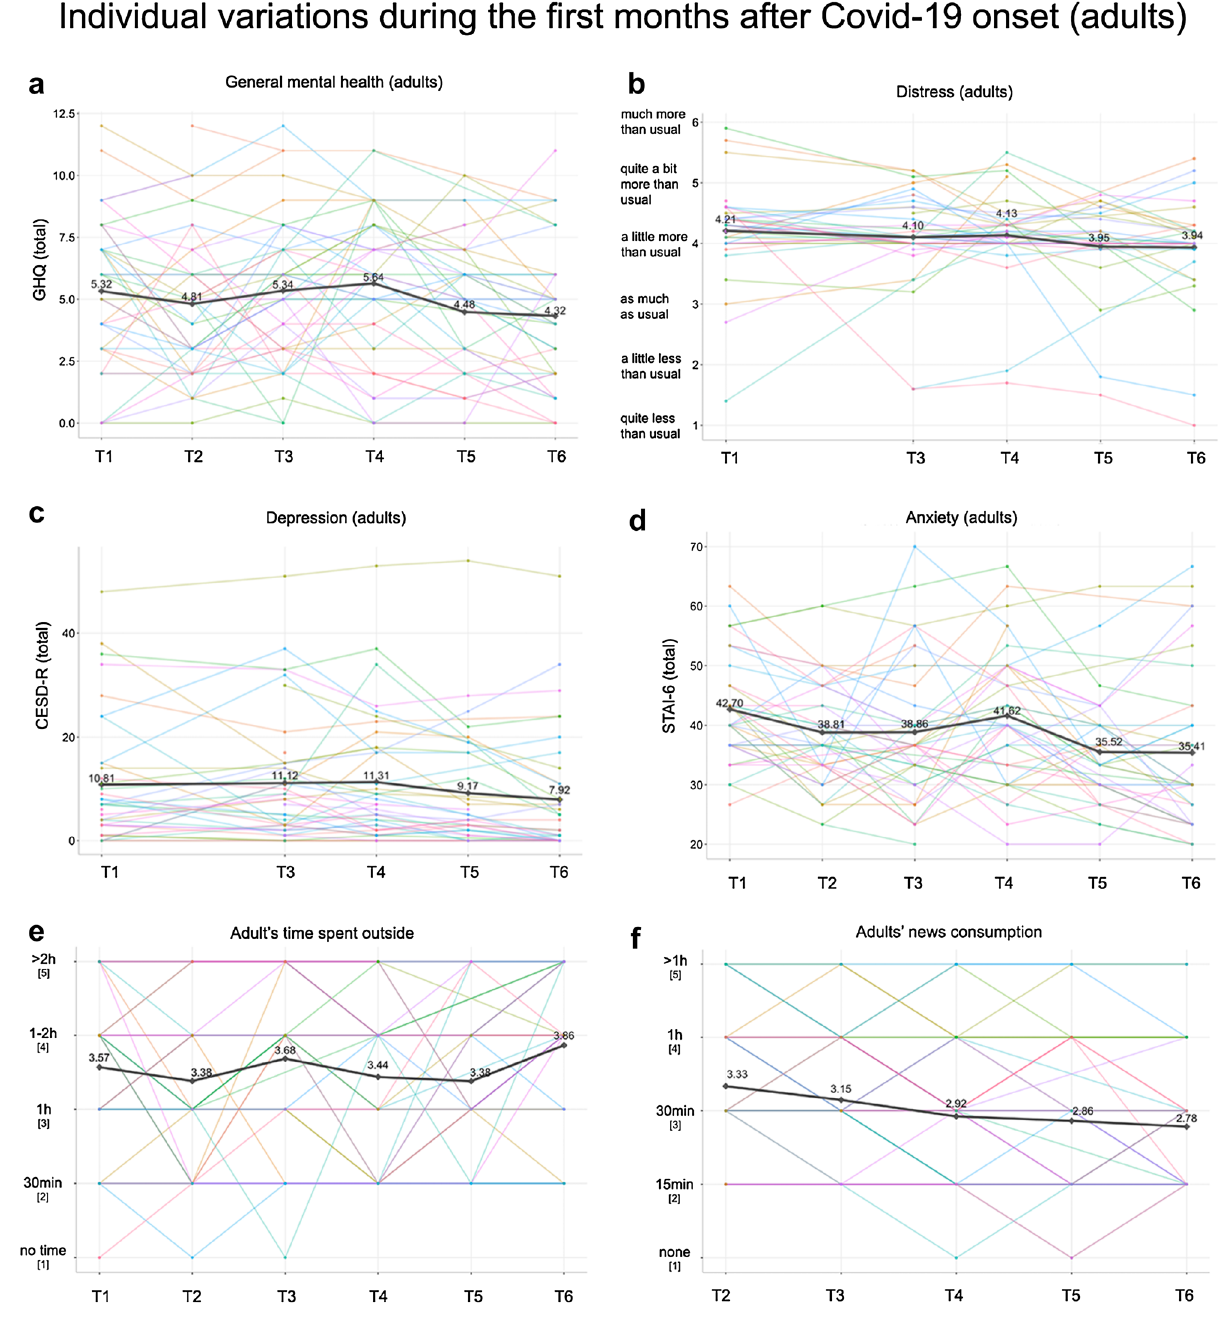
Figure 2. Variations of group mean (bold) and individual (colorful) scores in mental well-being across the first months after Covid-19 onset in adults. ( a ) Variation in scores of general mental health. ( b ) Variation in distress scores. ( c ) Variation in depression scores. ( d ) Variation in anxiety scores. ( e ) Variation in time spent outside. ( f ) Variation in news